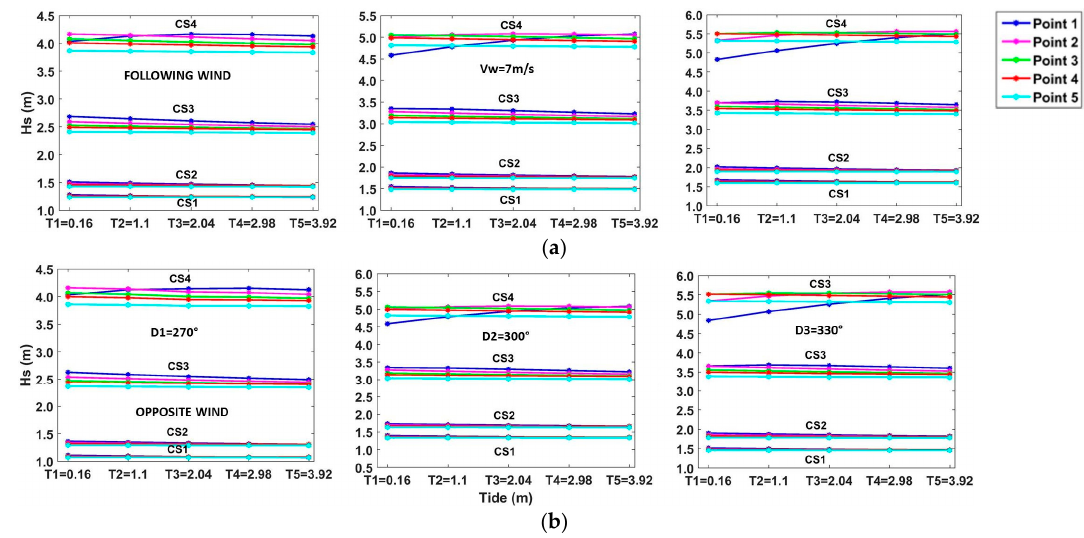
Figure 9. Average wind conditions ( V w = 7 m/s): H s variations along the reference points corresponding to the three different directions of the incoming waves (D1, D2, D3) and to the five tide conditions (T1, T2, T3, T4, and T5) for all the case studies considered (CS1, CS2, CS3, CS4): ( a ) following wind (FW); and ( b ) opposite wind (OW).